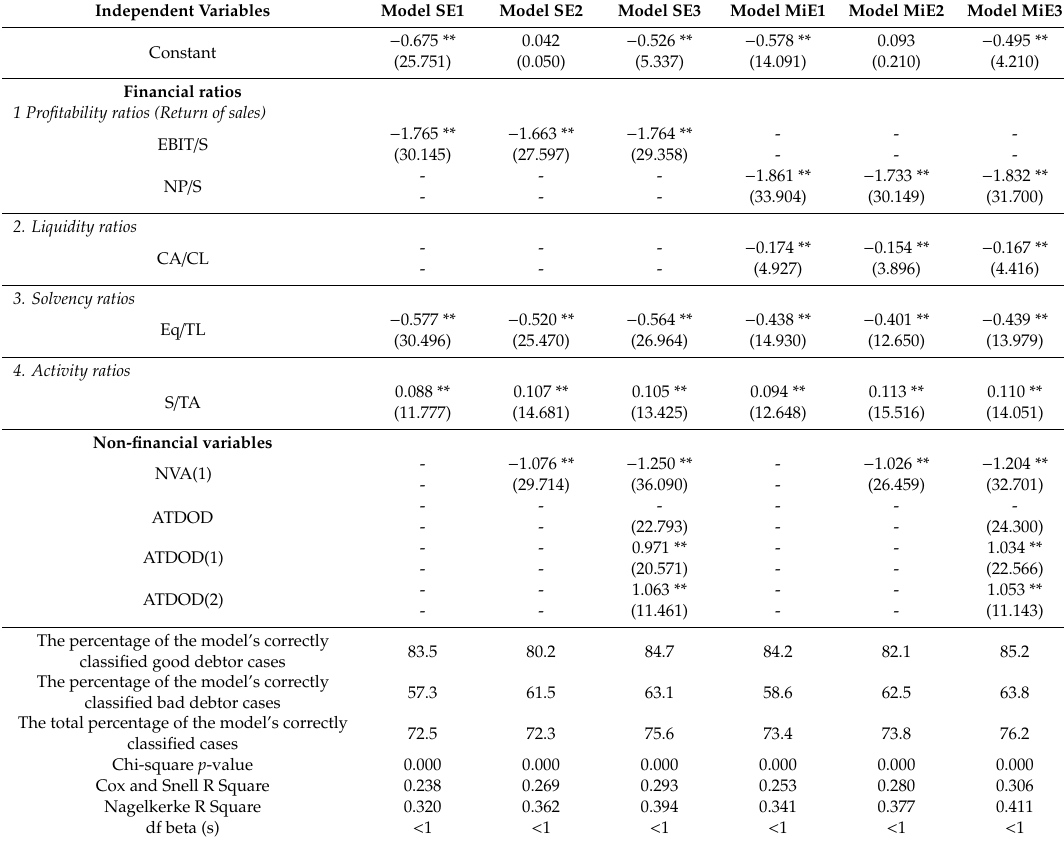
Table 1. Logistic regression enterprise trade credit risk assessment (ETCRA) models for small (SE) and micro-enterprises